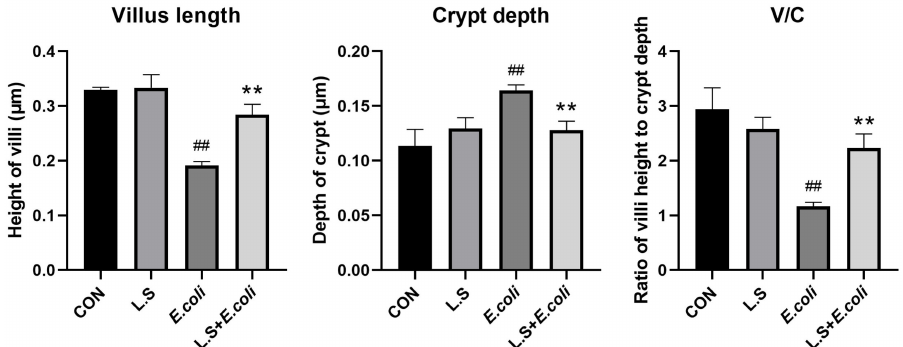
Figure 2. Villus length and crypt depth in mouse jejunum tissue and the ratio between them. Note: ## in the figure indicates a very significant difference compared with the CON group ( p < 0.01); ** indicates a very significant difference compared with the E. coli group ( p <